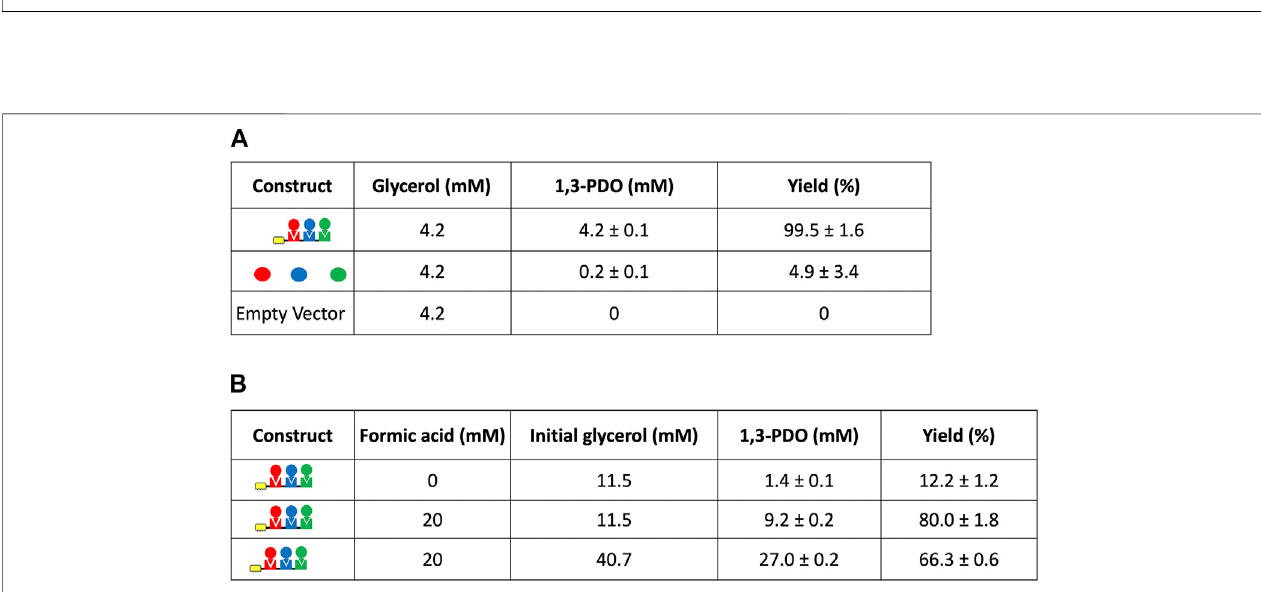
FIGURE 6 | Titers and yields of 1,3-PDO from glycerol using the self-assembling metabolon using low levels of glycerol to con fi rm the speci fi c binding to cellulose before production (5 mM NADH) and using higher levels of glycerol with formate as a sacri fi cial substrate for cofactor recycling to avoid stoichiometric use of NADH (16 mM NADH in the absence of formate and 1 mM in the presence of formate). All symbols are described in Figure 1 .